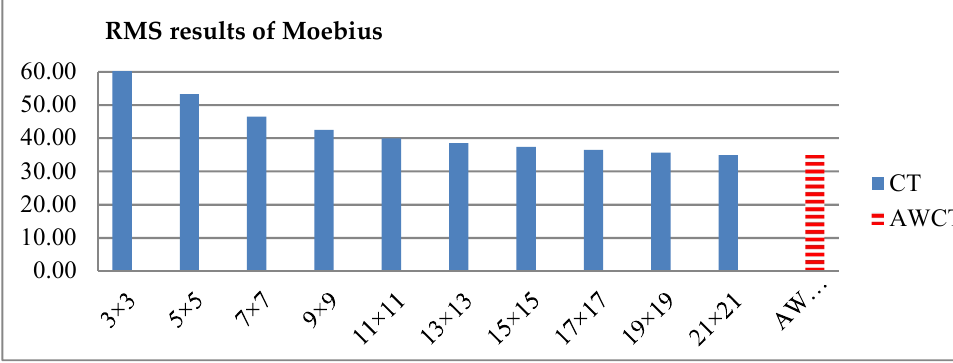
Figure 15. RMS comparison results of Moebius between AWCT and CT.